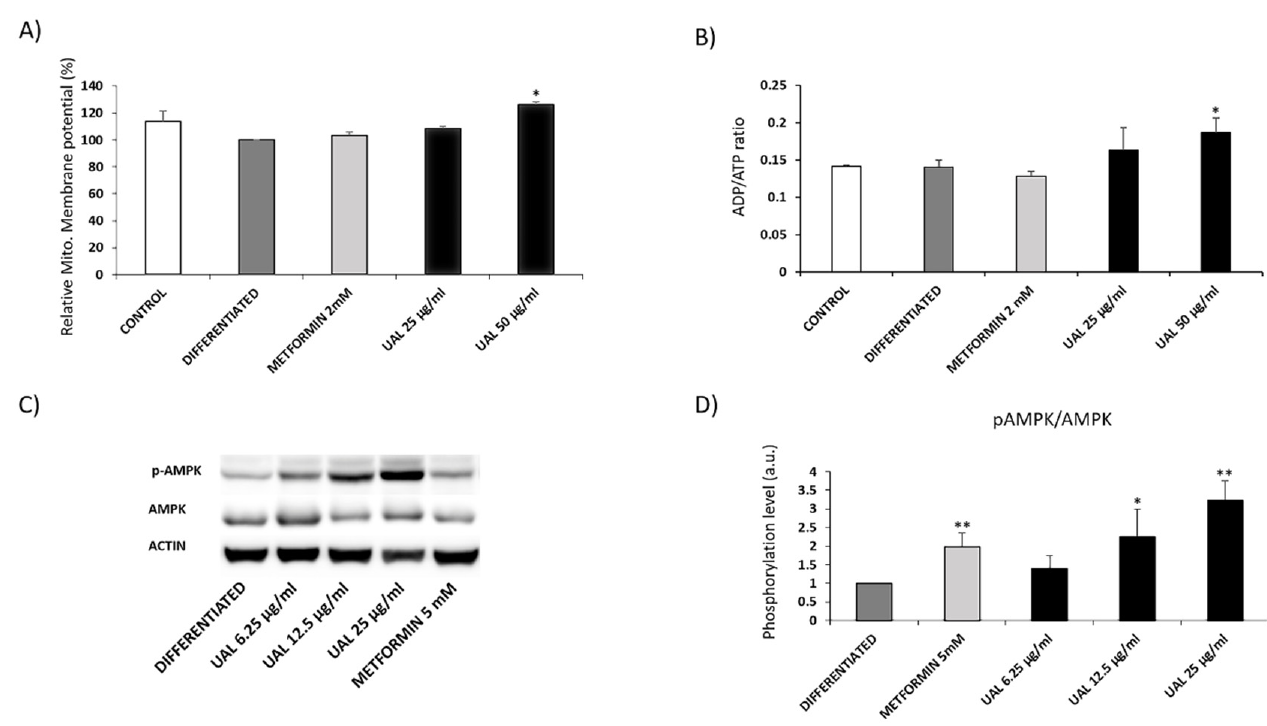
Figure 7. Effect of UAL on differentiated 3T3-L1 mitochondria and cellular AMPK expression. 3T3-L1 cells were differ- entiated and treated with UAL for 72 h. ( A ) Mitochondrial membrane potential was determined by quantification of Mito tracker-loaded cells fluorescence. Values are expressed as mean ± SEM of three independent experiments each one performed in duplicate. ( B ) ADP/ATP ratio in 3T3-L1 adipocytes treated with UAL. Values are expressed as mean ± SEM of three independent experiments each one performed in triplicate ( C ) Representative western blots of phosphorylated AMPK in differentiated 3T3-L1 cultures treated with UAL. ( D ) Quantitative analysis of the immunoblots of p-AMPK normalized with total AMPK. Values are expressed as mean ± SEM of three independent experiments. * p < 0.05, ** p < 0.01 compared with DIFFERENTIATED (ANOVA with Dunnett ´ s post hoc test).